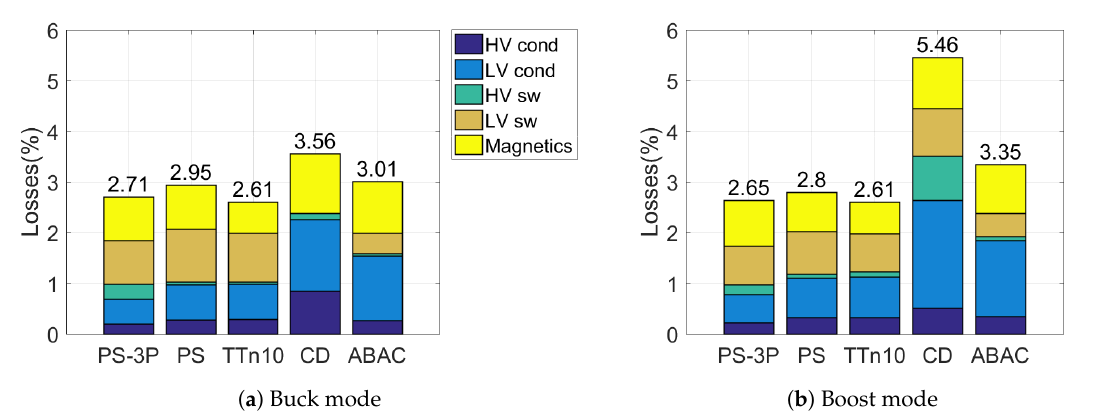
Figure 11. Average losses in % (converter losses divided by transferred power), including losses